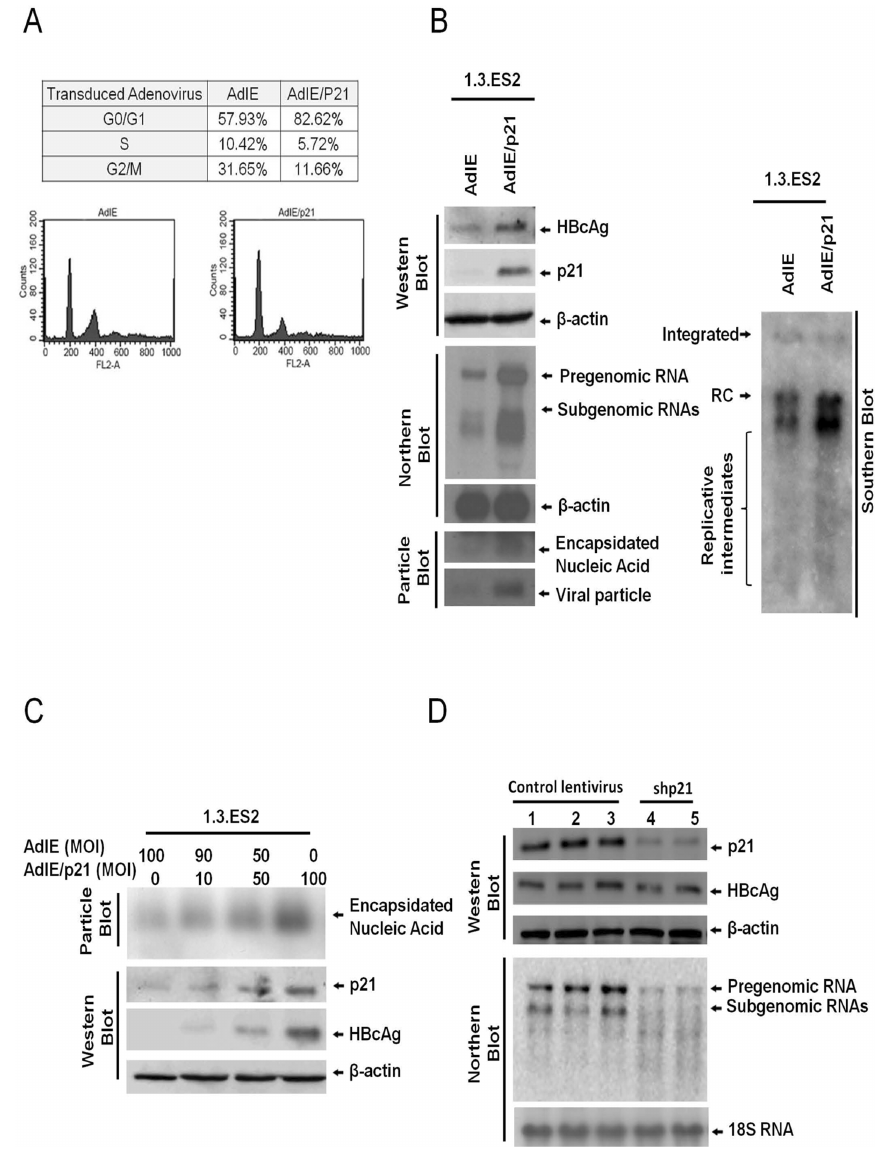
Fig 2. Expression level of p21 modulates HBV replication in 1.3.ES2 cells. (A) Cell cycle analysis of 1.3. ES2 cells with p21 overexpression. 1.3.ES2 cells were transduced with AdIE (a mock control adenovirus) or with AdIE/p21 (an adenovirus carrying the p21 gene). Next the cell cycle distribution was analyzed by flow cytometry assay. (B) The effect of p21 overexpression on the modulation of HBV replication. Cell lysates were extracted from adenoviruses-infected 1.3.ES2 cells, and the levels of HBV genomes and HBV transcripts were examined by Southern and Northern blot analysis using a HBV-specific probe. The expression of beta-actin was used as the loading control in the Northern blot. The expression of HBV nucleocapsids and the embedded viral genome were detected by particle blot analysis. The expression levels of HBcAg and p21 were analyzed by Western blot assay. (C) The dosage effect of p21 on the modulation of HBV replication. 1.3.ES2 cells were transduced with different amounts of AdIE and/or AdIE/ p21, and equal amounts of cell lysates were subjected to native agarose gel electrophoresis to allow particle blot analysis. The encapsidated viral genomes were detected using a HBV-specific probe. (D) Effect of p21 knock-down on the modulation of HBV replication. 1.3ES2 cells were infected with lentiviruses that expressed control shRNA or shRNA against p21. Four days after lentivirus infection, the cells were harvested for Northern blot and Western blot analysis. Lanes 1, 2 and 3 contained control virus samples (vector alone, shRFP and shLuc, respectively), while Lanes 4 and 5 contained cells transfected with two different shCDKN1As; these were sh-CDKN1A-A1 and sh-CDKN1A-G1, respectively.